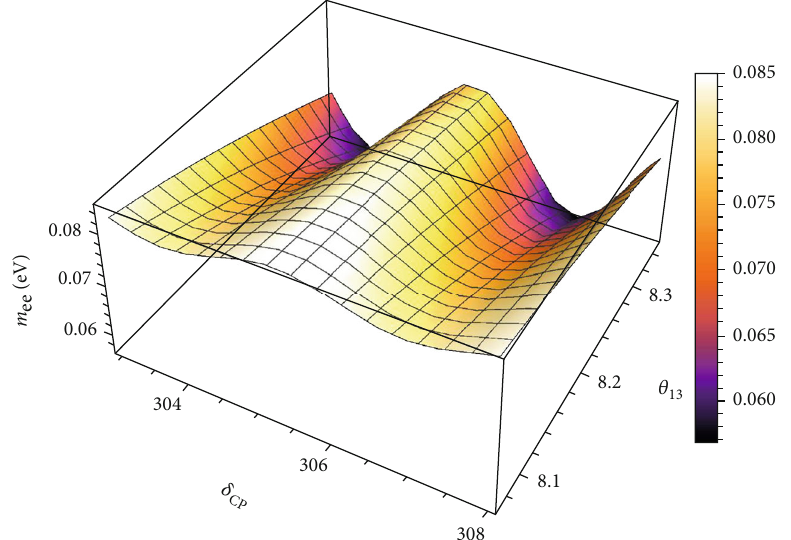
Figure 13: Predictions in the broken μ − τ symmetry model for normal ordering. (a) Depicts the predicted three-dimensional space of Þ for m ð m , δ , m [eV], 0 νββ decay for favoured values of m CP 1 ee ee density bounds, 5 : 8 × 10 − 10 < η < 6 : 6 × 10 − 10 ). Depicts predicted three-dimensional space of ð m favoured values of m , δ , m for values of δ in the given three σ range, corresponding to Δχ 2 = 9 : 5 w/o SK-ATM 1 CP CP ee